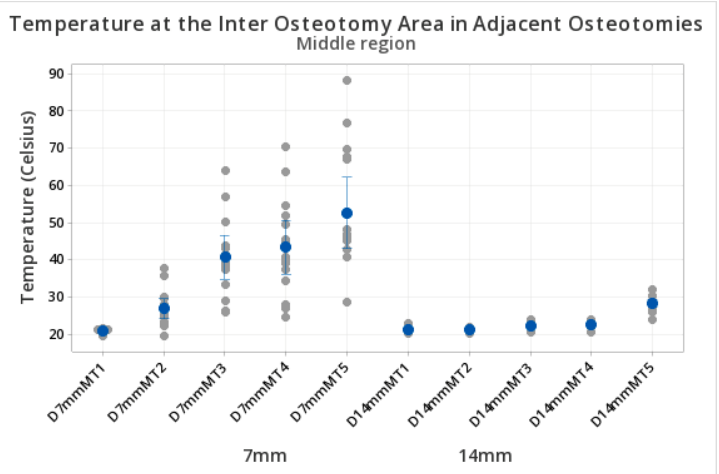
Figure 5. Temperature in the inter-osteotomy area. Measurements at the middle level. The y axis shows the temperature reached during the preparation of the osteotomies. The x axis indicates the different test groups at 7 mm and 14 mm inter-osteotomy separations at the middle level. Ascending temperatures were observed in both groups and influenced by the time and separation between osteotomies. D = distance, M = middle, T = time (T1 = 20 s, T2 = 40 s, T3 = 60 s, T4 = 80 s, T5 = 100 s). The blue dots represent the central mean value. The grey dots represent the distribution of upper and lower temperatures (sometimes overlapping). The blue lines if present, represent standard deviations.